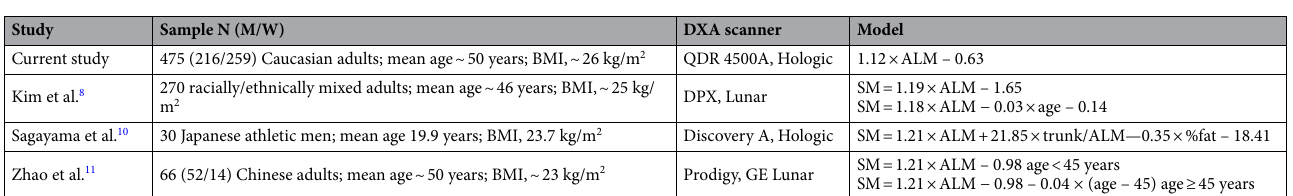
Table 4. Comparison of previously reported and current SM prediction models. Mass units, kg; Sex, 0, woman; 1, man. A age, ALM appendicular lean mass, BMI body mass index, M men, SM skeletal muscle, W